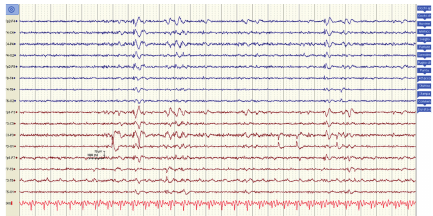
Figure 4: A follow-up EEG obtained seven months later revealed a normal background activity, although isolated diffuse polyspike dis- charges time-locked with myoclonic jerks persisted, more evidently in the anterior